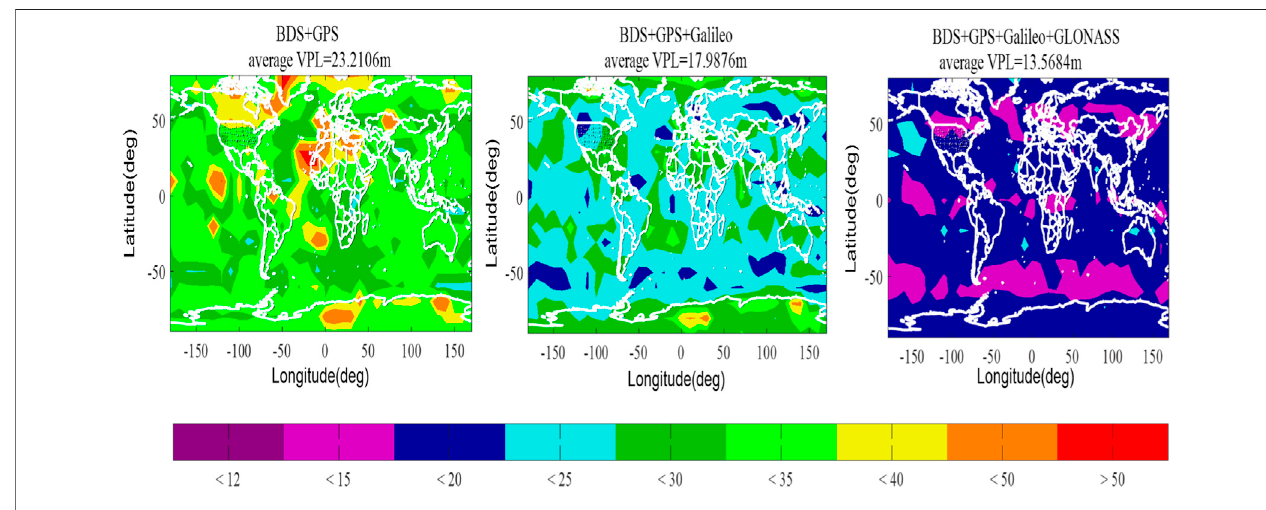
FIGURE 5 | VPL under different constellation numbers after